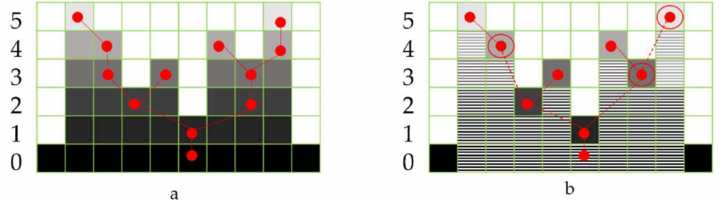
Figure 1. ( a ) Component tree and ( b ) Max-tree of sample image f = {0, 5, 4, 2, 3, 1, 4, 3, 5, 0}. The composite nodes are depicted by double circles and the filled pixels in each horizontal connected component represent the pixels each node